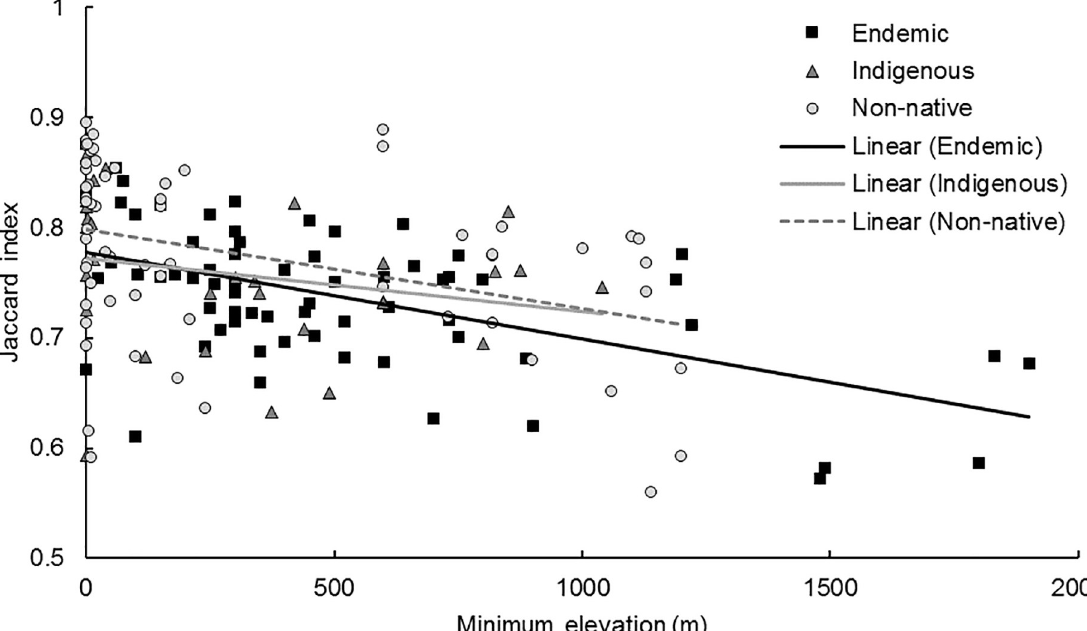
Fig 6. Species specialization by minimum elevation. A linear model was developed to determine if habitat specialization (Jaccard index) differs by minimum elevation and biogeographic origin. Plant species restricted to high elevations had lower Jaccard index values than those with low or no minimum elevation limit ( p < 0.001; Table 6).